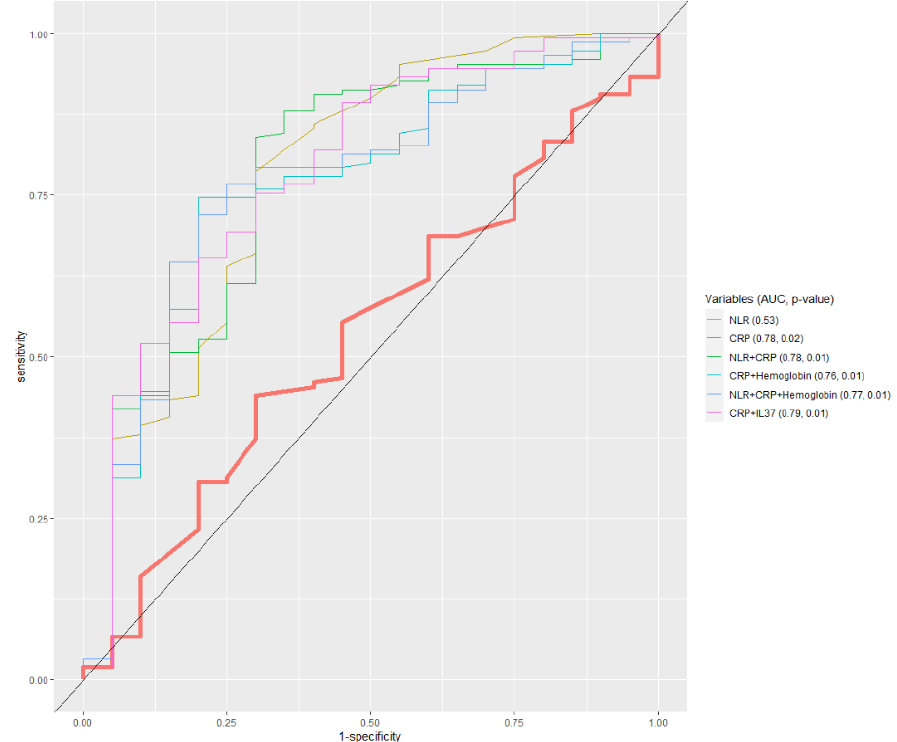
Figure 6. ROC model which discriminates between underweight diabetic patients (BMI < 25 kg/m 2 ) and overweight/obese ones (BMI 25 – 30, and >30 kg/m 2 ).